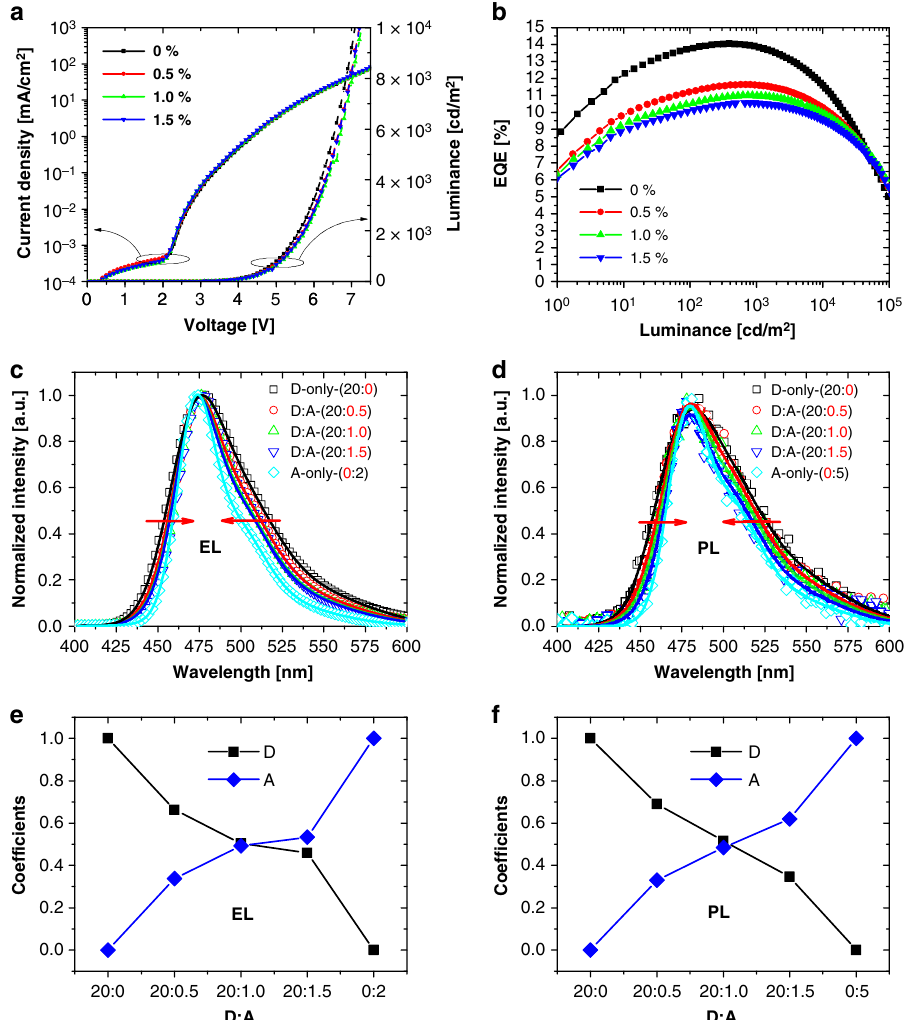
Fig. 4 Characteristics of the light-emitting diodes (OLEDs) using mixed emission layers. The acceptor concentration was varied from 0 to 1.5%. a J-V-L characteristics. b External quantum ef fi ciency vs luminance. c Normalized electroluminescence spectra and d normalized photoluminescence spectra. Donor-only and acceptor-only photoluminescence spectra were fi tted with three Gaussian peaks. The mixed samples were fi tted with linear combinations of the donor-only and acceptor-only fi ts: e and d show the donor and acceptor coef fi cients with respect to the acceptor